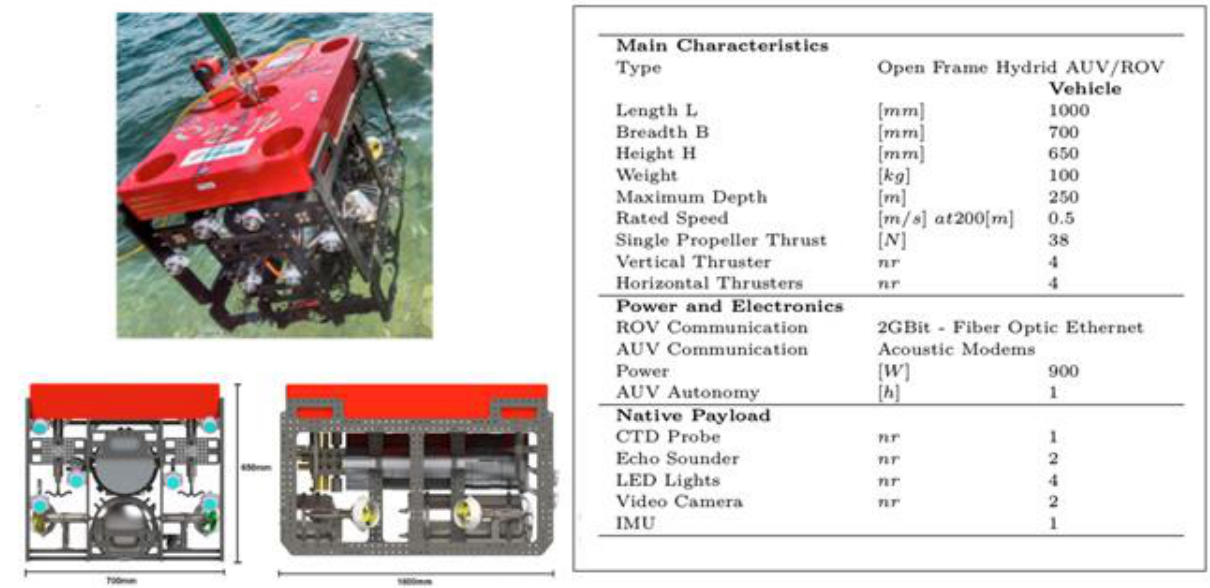
Figure 4. The e-URoPe (e-Underwater Robotic Pet) hybrid ROV/AUV system of CNR-INM. On the left, a picture and two renderings of the robotic platform are shown. On the right, a table with the main characteristics of the robotic vehicle.